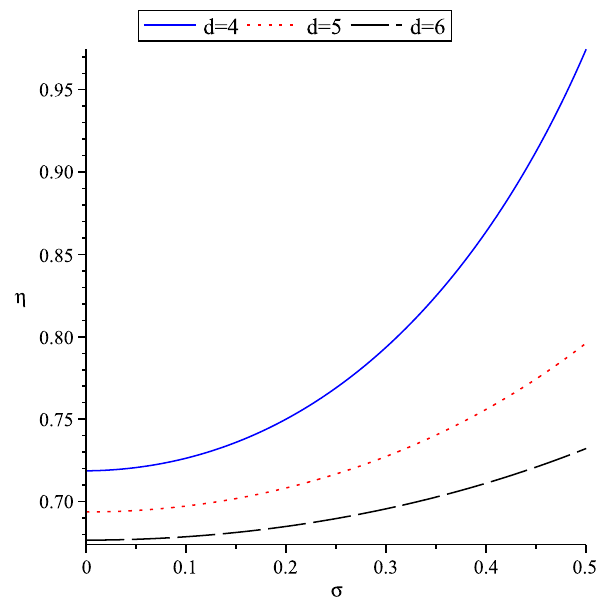
Fig. 7 Efficiency of the squared cycle as a function of the string cloud parameter